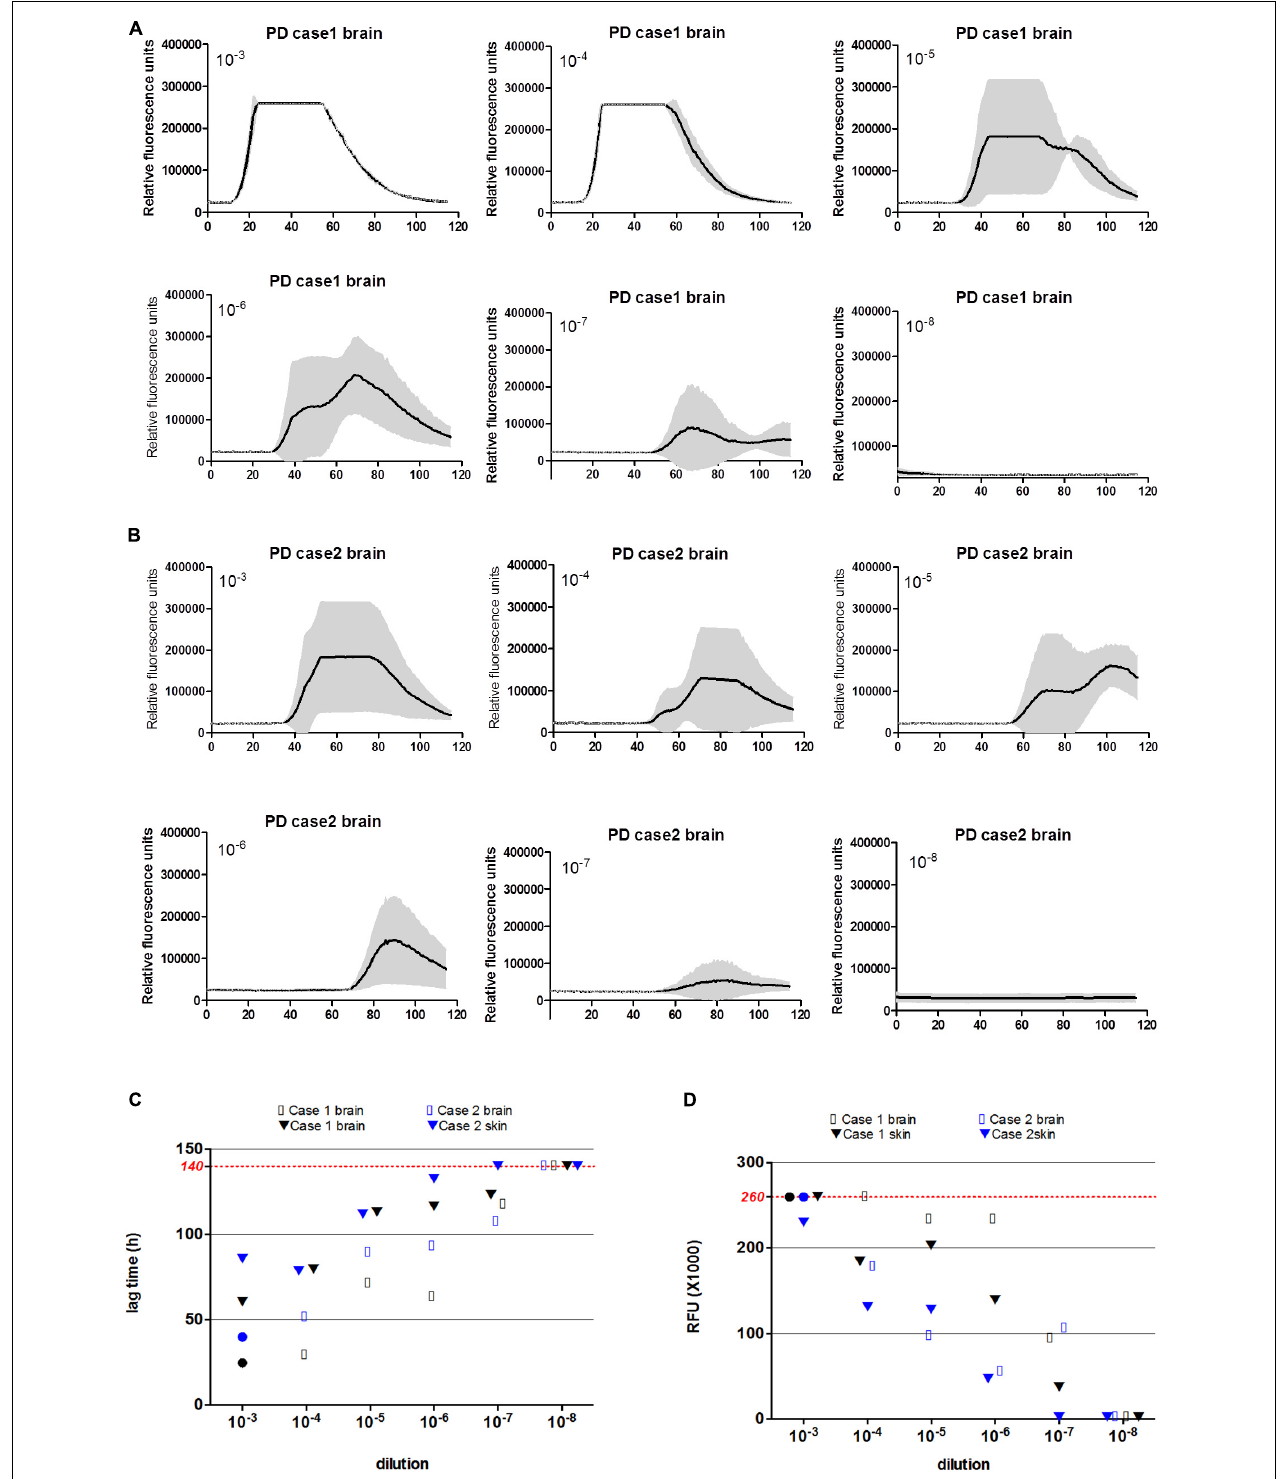
FIGURE 3 | α -Syn RT-QuIC of serially diluted brain and scalp skin homogenates of two neuropathologically confirmed PD cases. (A) α -Syn RT-QuIC spectra of Case 1. (B) α -Syn RT-QuIC spectra of Case 2. The dilutions are indicated on the top. Y -axis represents rfu (ThT value). X -axis represents the time (h) post-reaction. Each reaction consists of 3 duplicates. (C) The lag times of serially diluted (from 10 − 3 to 10 − 8 ) paired brain and skin specimens of two PD cases. Maximal reaction time (140 h) is indicated with red dot line in the graph. (D) The peak rfu values of serially diluted (from 10 − 3 to 10 − 8 ) paired brain and skin specimens of two PD cases. Maximal detecting limitation of ThT value is indicated with red dot line in the